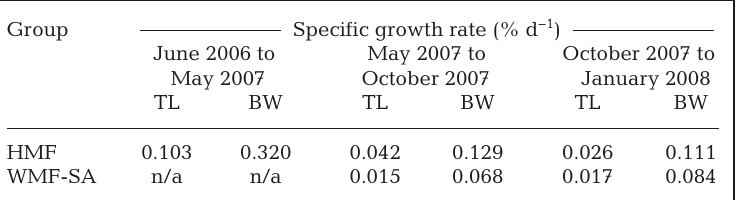
Table 2. Specific growth rate in terms of total length (TL) and body weight (BW) between hatchery-reared mandarin fish (HMF) and wild mandarin